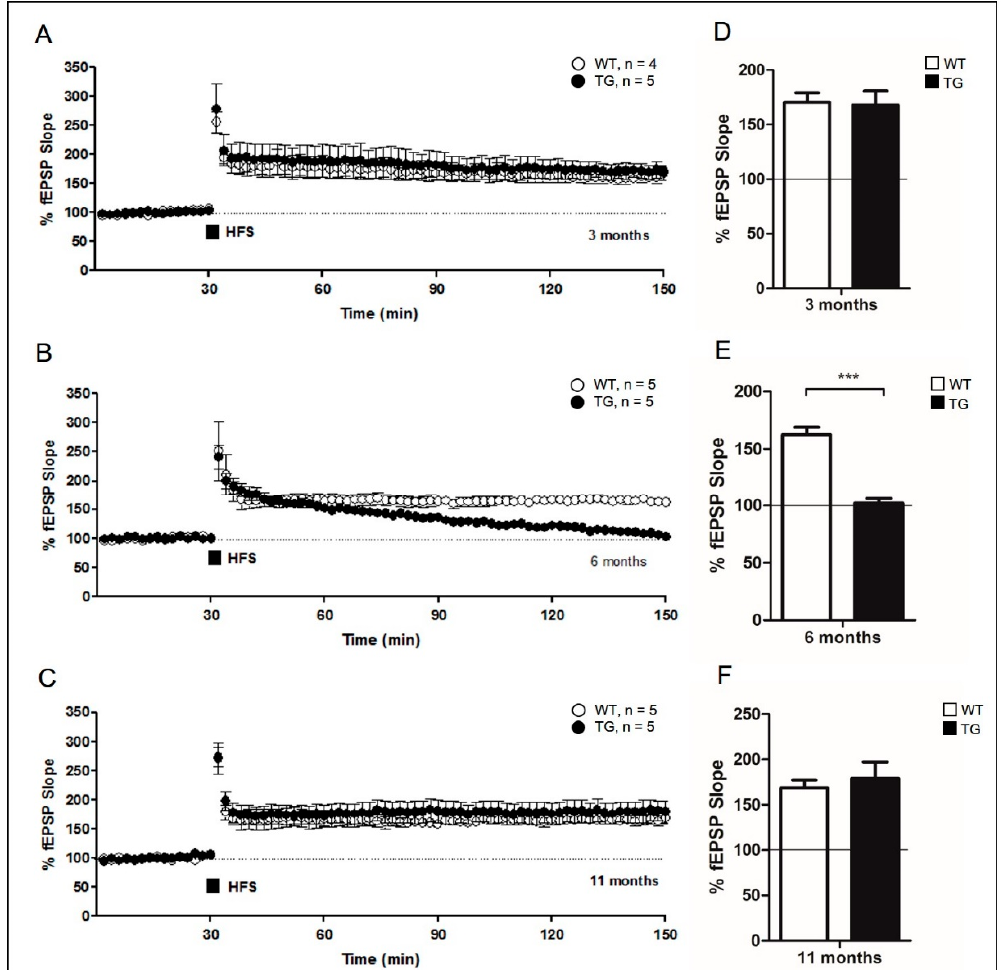
Figure 2. Evaluation of synaptic plasticity in aged AD mice. ( A – C ) Two trains of tetanus stimuli (100 Hz for 1 s, with a 30 s inter-tetanus interval) were applied to the Schaffer collateral pathway, which induced long-term potentiation in the hippocampal CA1 region. ( D – F ) Summary of these results. Data are displayed as the mean ± SEM (***, p < 0.0001 compared with the indicated group using unpaired t -test). fEPSP, field excitatory postsynaptic potential; WT, wild-type; TG, transgenic; HFS, high-frequency